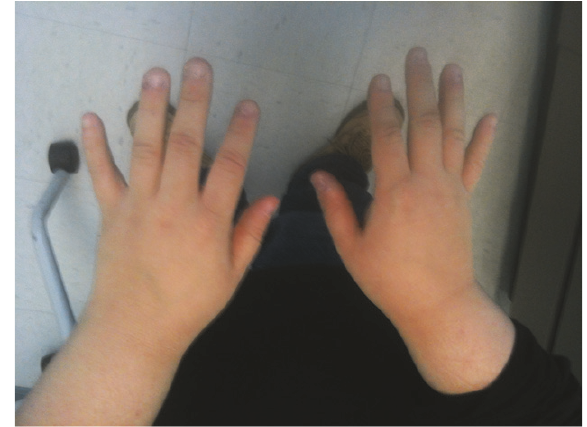
Figure 2: Small hands characteristic of Prader-Willi